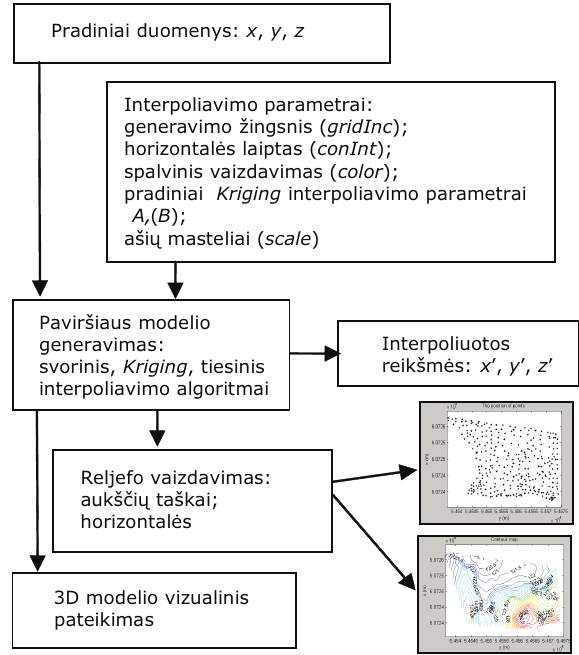
Fig. 1. Surface modeling workflow used in Geo3D program